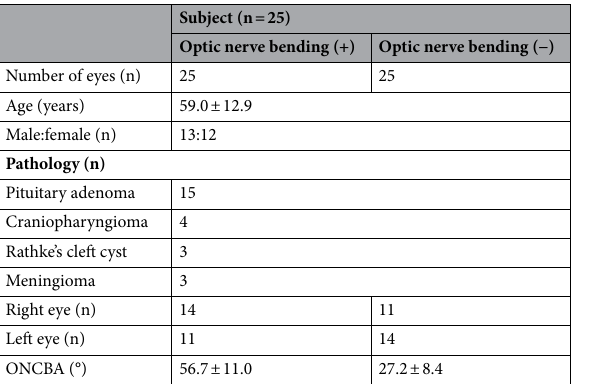
Table 1. Systemic characteristics of patients with sellar and suprasellar tumors. ONCBA optic nerve–canal bending